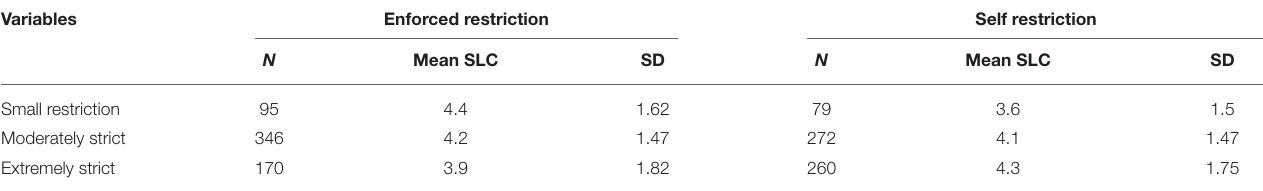
TABLE 10 | Average stress-level change (SLC) by three levels of restrictions (enforced restriction vs. self